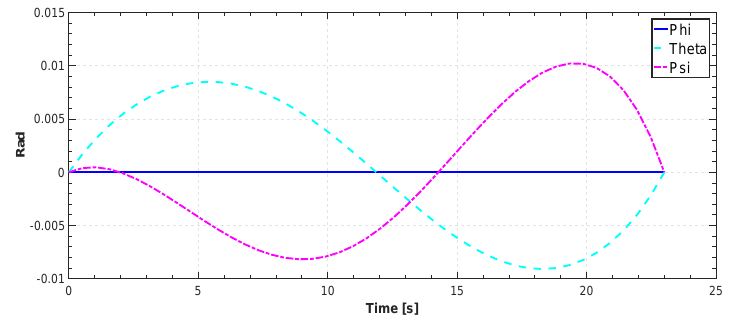
Figure 21. Complex maneuvering in 3D space (CMS).